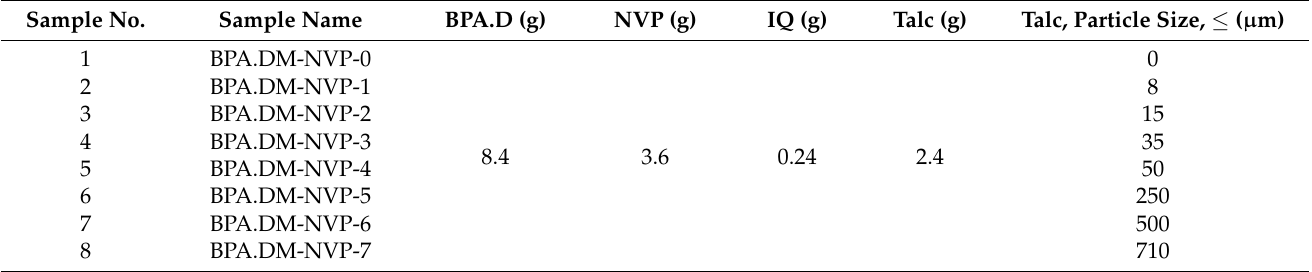
Table 1. Experimental parameters of the